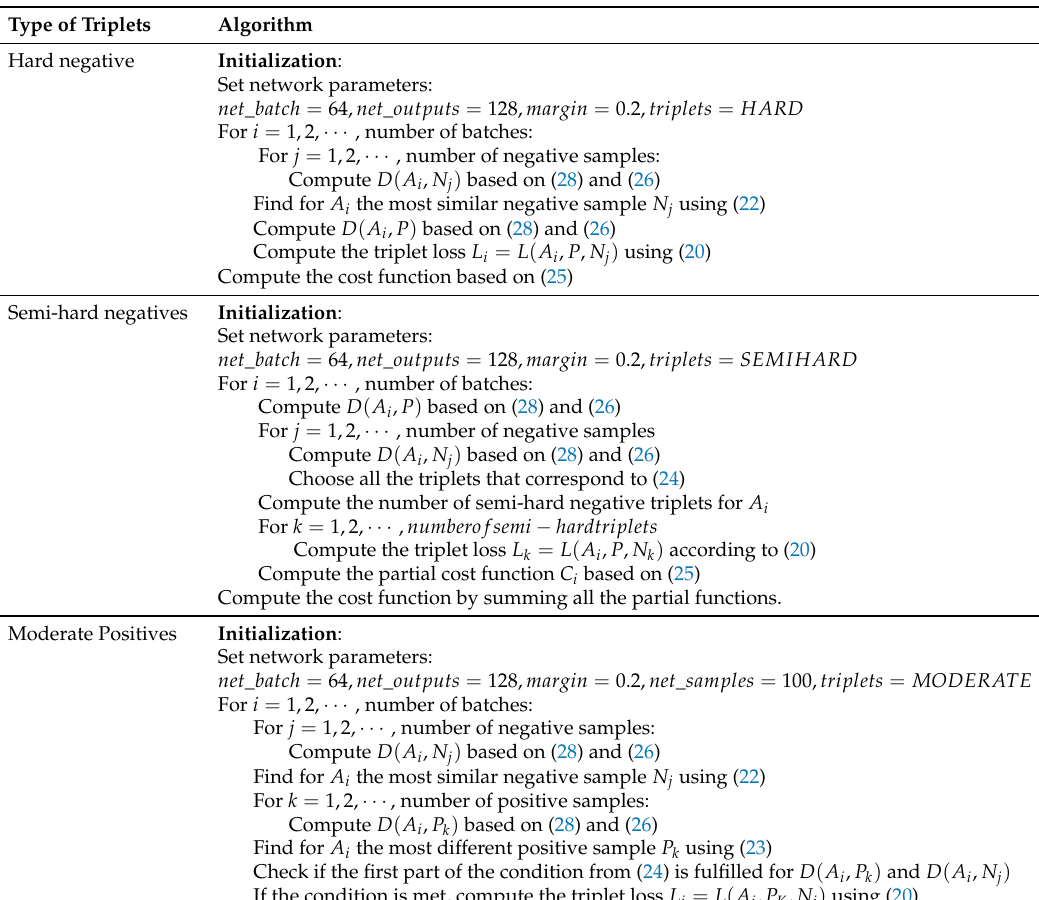
Table 4. Types of triplets implemented in our proposed